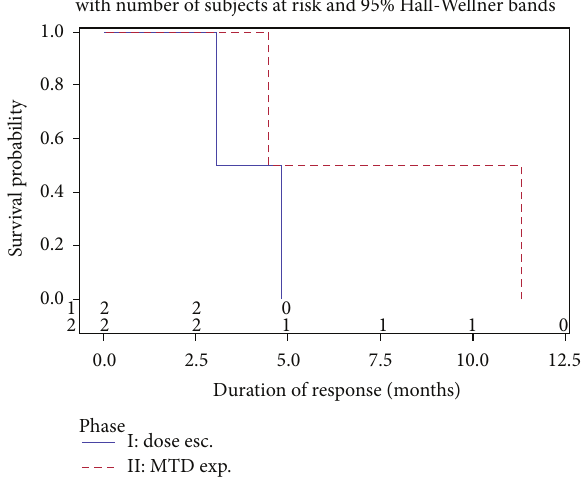
Figure 4: Duration of response for phase I and phase II.